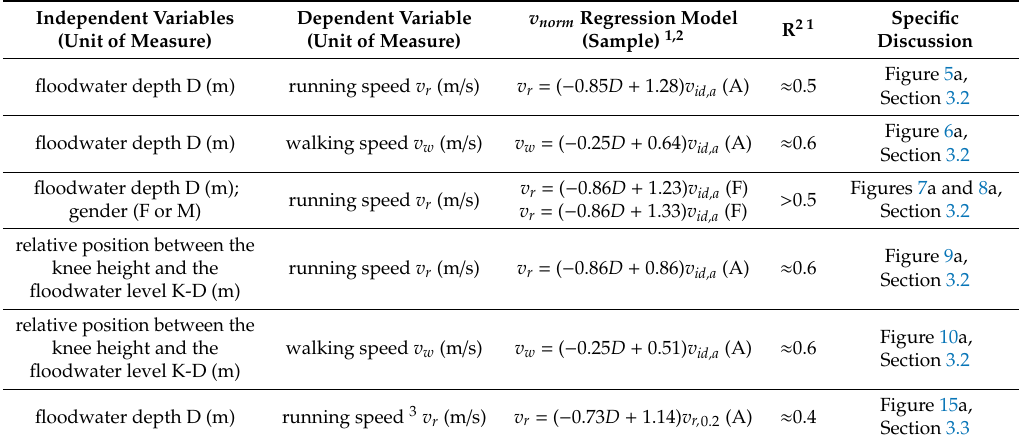
Table 2. Selected modelling approaches based on non-dimensional dependent variables. In the regression model column, the expression inside round brackets is v norm